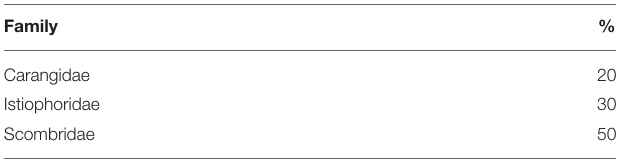
TABLE 2 | Taxonomic composition assumed to be caught in the recreational fishery.